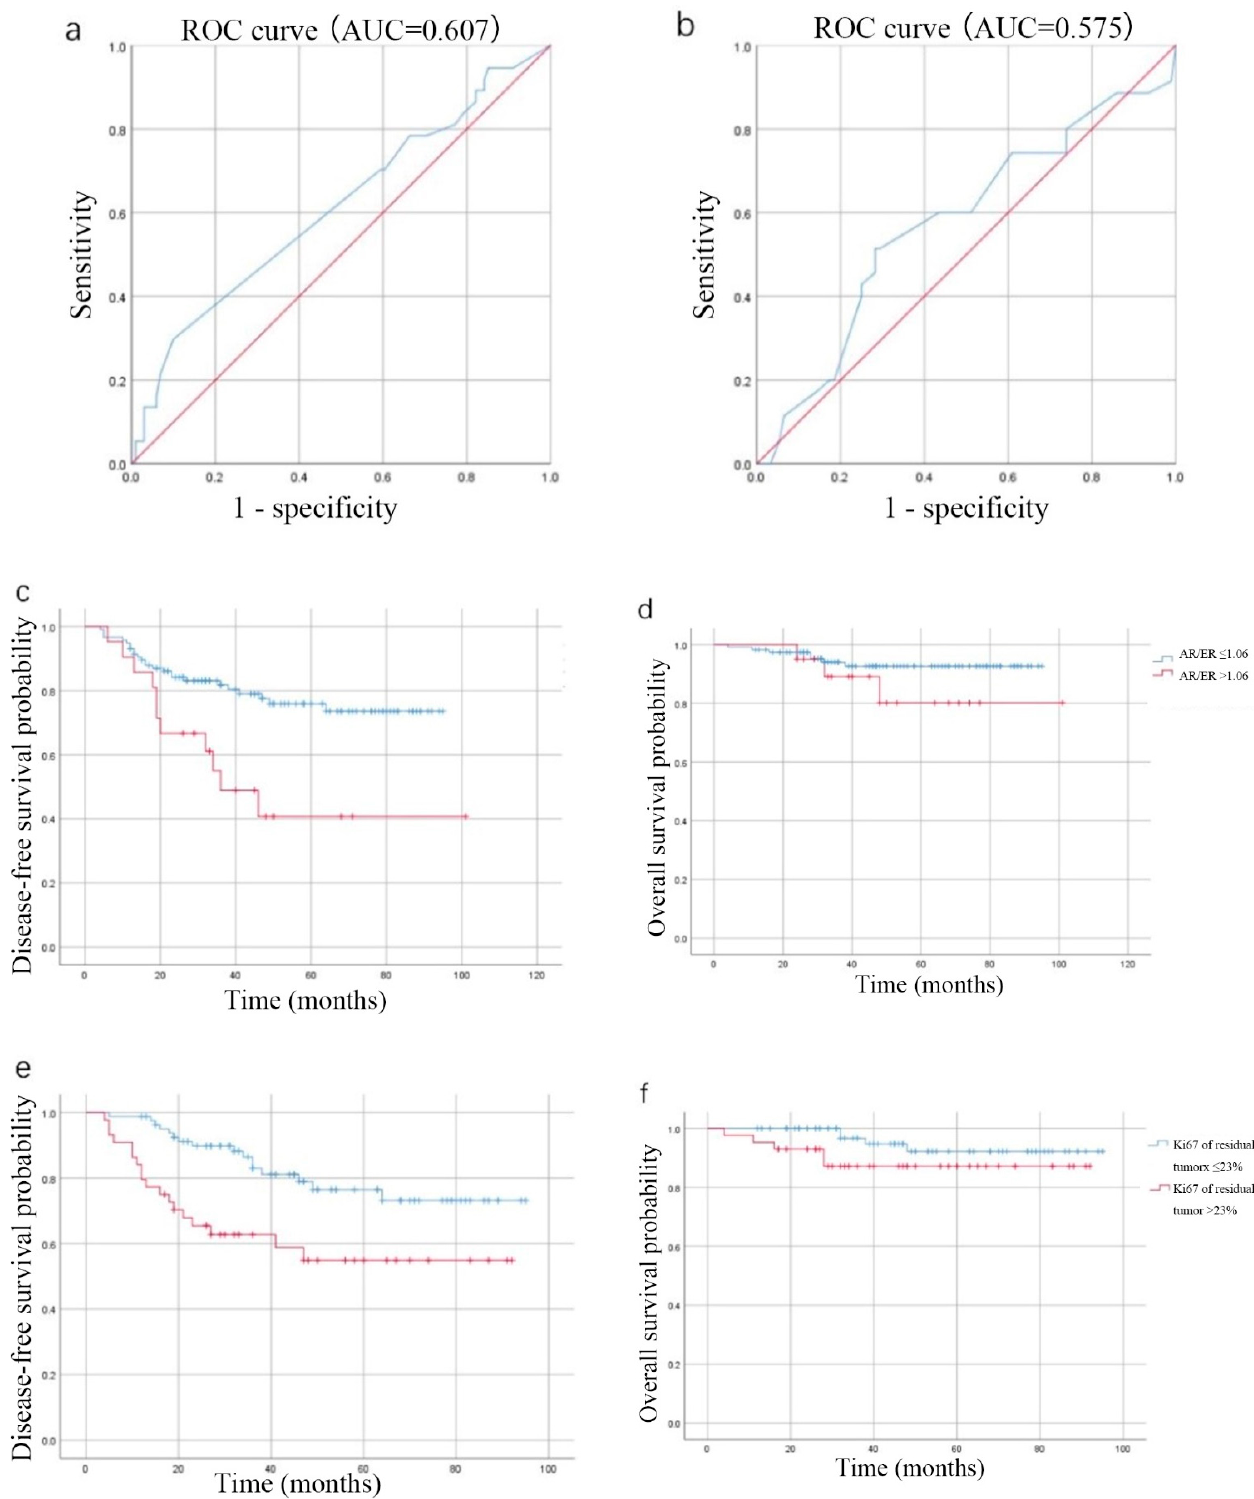
Figure 3. ( a ) ROC curve of AR/ER for predicting DFS events. ( b ) ROC curve of residual tumor Ki67 for predicting DFS events. ( c ) Kaplan-Meier analysis of DFS with an AR/ER cutoff value of 1.06. ( d ) Kaplan–Meier analysis of OS with an AR/ER cutoff value of 1.06. ( e ) Kaplan–Meier analysis of DFS with a residual tumor Ki67 cutoff value of 23%. ( f ) Kaplan ‒ Meier analysis of OS with a residual tumor Ki67 cutoff value of 23%. AR, androgen receptor; ER, estrogen receptor; DFS, disease–free survival; OS, overall survival.